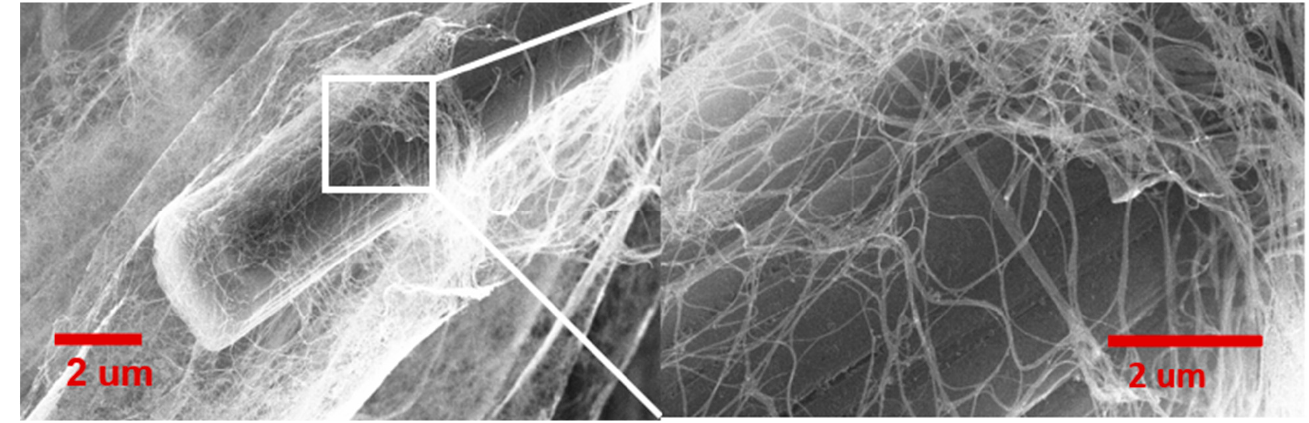
Figure 16. SEM image of chopped carbon fiber integrated into the intertangled web of CNT fabric.